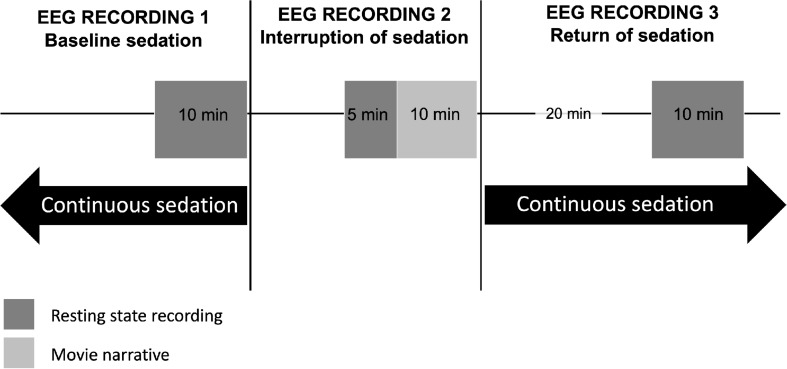
Schematic timeline of EEG recordings before, during, and after a brief interruption of continuous sedation. In the ICU, between 24 h and 7 days post-injury, continuously-sedated brain-injured patients will have their brain activity recorded using high-density EEG during 10 min at resting state, under continuous sedation (EEG Recording 1). The clinical team will then interrupt sedation to carry out their neurobehavioral assessment, as standard of care. Following this assessment, sedation will continue to be withheld for 15 additional minutes, during which EEG will be recorded for 5 min at resting state, and 10 min during which an auditory narrative will be played through headphones, in its scrambled (5 min) and intact form (5 min) (EEG Recording 2). Twenty minutes after continuous sedation is reinstated, a final 10-min resting state EEG recording will take place (EEG Recording 3).